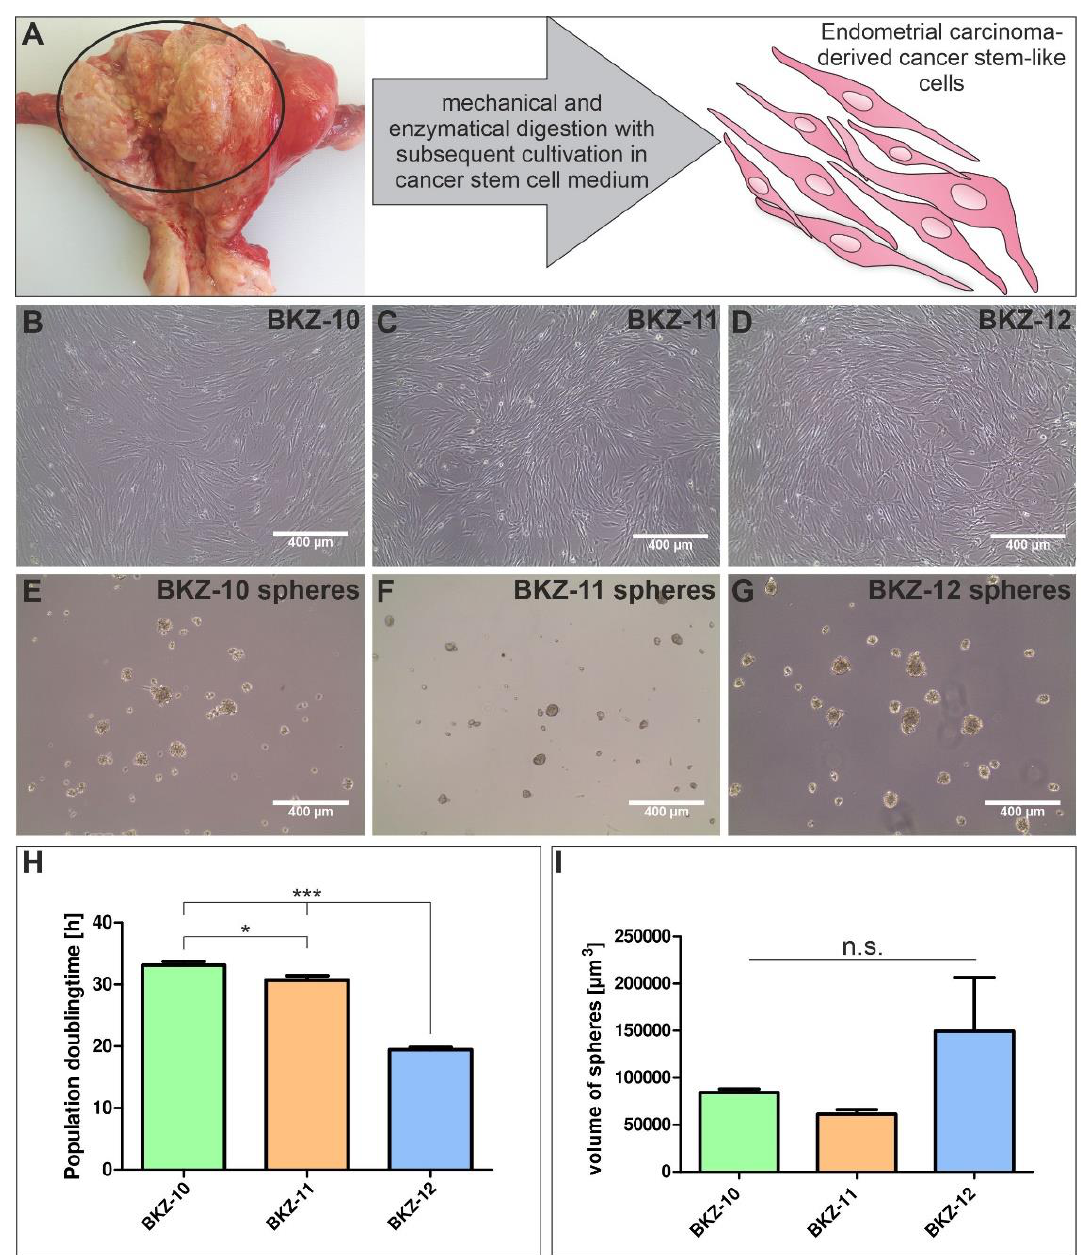
Figure 1. Establishment of endometrial carcinoma-derived stem-like cell populations. ( A ) For the isolation of endometrial carcinoma-derived stem-like cell populations, endometrial carcinoma tissue samples were obtained, mechanically and enzymatically digested and cultivated in cancer stem cell medium either supplemented with 10% fetal calf serum leading to ( B – D ) adherently growing cells or 4 µ g/mL heparin for ( E – G ) sphere formation. ( H ) Quantification of population doubling time of BKZ-10, BKZ-11 and BKZ-12 revealed a significantly lower population doubling time for BKZ-12 in comparison to BKZ-10 and BKZ-11. Moreover, BKZ-10 exhibited a significantly higher population doubling time than BKZ-11. Quantification of the ( I ) volume of spheres showed a higher sphere volume for BKZ-12 in comparison to BKZ-10 and BKZ-11. Unpaired t -test ( p ≤ 0.05). n = 3, * p ≤ 0.05, *** p ≤ 0.001. Means ± SEM (standard error of the mean).